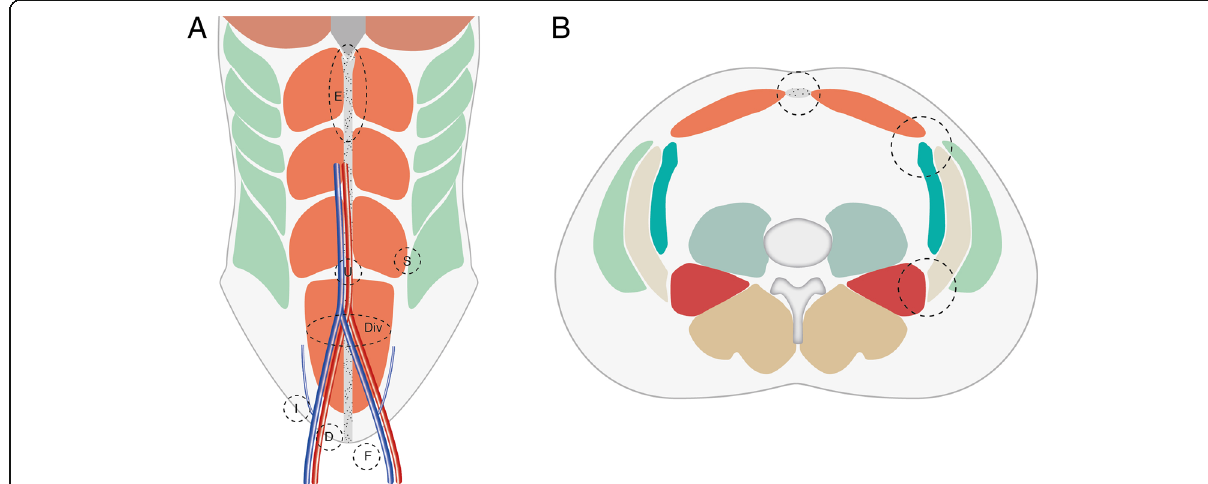
Fig. 1 a Schematic coronal drawing of the anterior abdominal wall muscles with the typical hernia locations marked by circles with dotted lines. Abbreviations stand for: E epigastric, S Spigelian hernia (between rectus and oblique abdominal muscles), Div rectus divarication, I indirect inguinal hernia (lateral to the origin of the epigastric vessels), D direct inguinal hernia (medial to the epigastric vessels), F femoral (inferior to the inguinal ligament and medial to the femoral vein), U umbilical. b Schematic axial drawing of the abdomen with hernia locations marked by the circles with dotted lines. Anteriorly, in the midline there is the umbilical or paraumbilical hernia (small circle). Between the recti (orange) and the transverse (dark green), internal oblique (beige) and external oblique (light green) abdominal muscles there is the Spigelian hernia and the interparietal wall hernia also occurs here. Posterolaterally, the lumbar hernia arises between the internal oblique abdominal muscle and the quadratus lumborum muscle